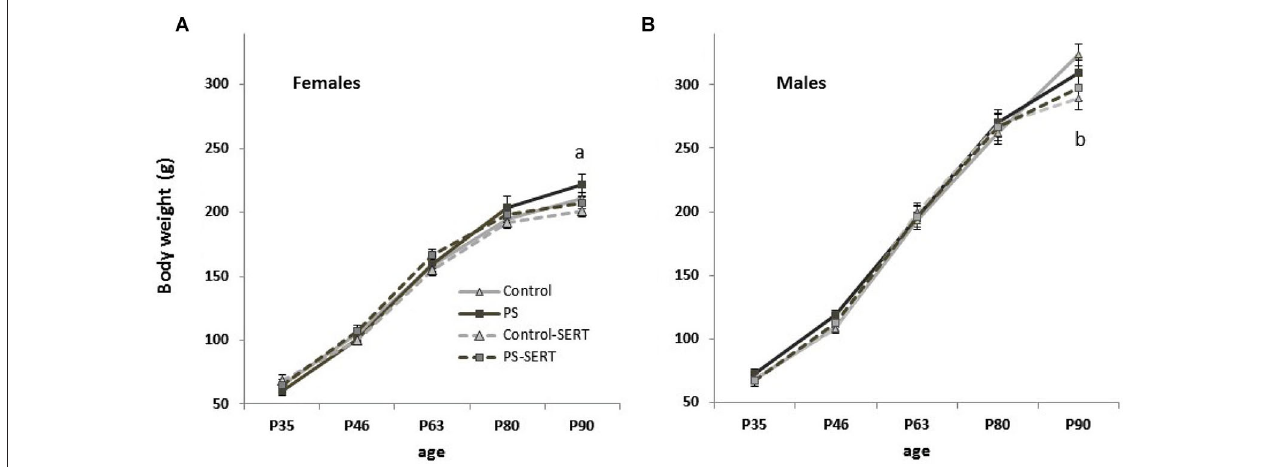
FIGURE 1 | Effects of prenatal stress and SERT treatment (5 mg/kg/day) on body weight gain (g) over time in females (A) and males (B) ( n = 9–11 animals per group and sex) . a, p < 0.05 indicates a main effect of prenatal stress; b, p < 0.05, indicates a main effect of SERT in Control-SERT vs. Control (Means ± standard